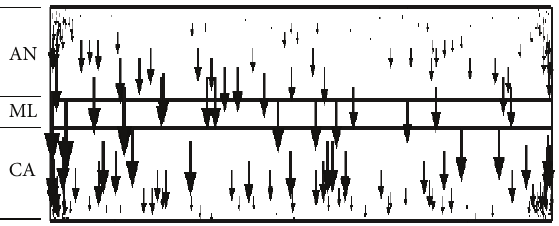
Figure6:Electronicfluxfromanodetocathodeinelectrolytephase. The vectors lengths indicate the flux magnitude which varies from 0 to 1𝑒 − 11 mAcm −2 in the same case as in Figure